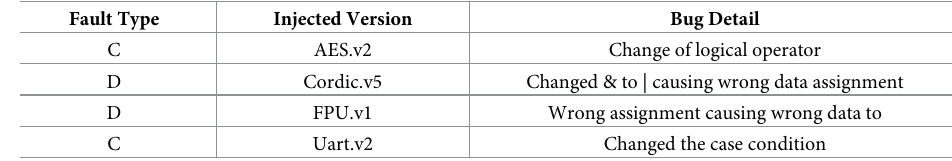
Table 3. Sample of fault